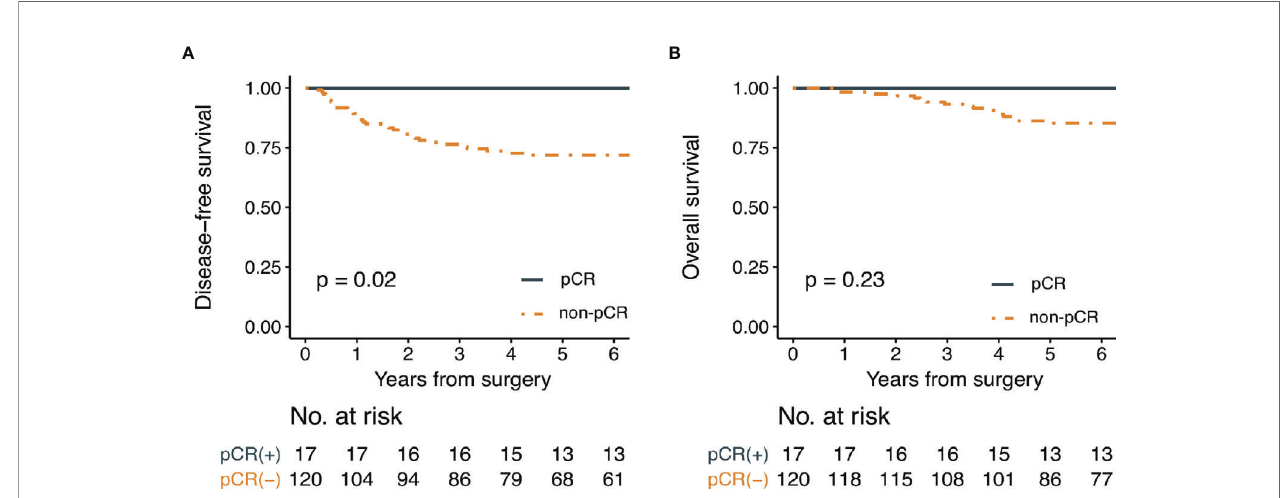
FIGURE 4 | Kaplan-Meier survival curve analysis for (A) disease-free survival and (B) overall survival in patients with or without pathologic complete response. (pCR; pathologic complete